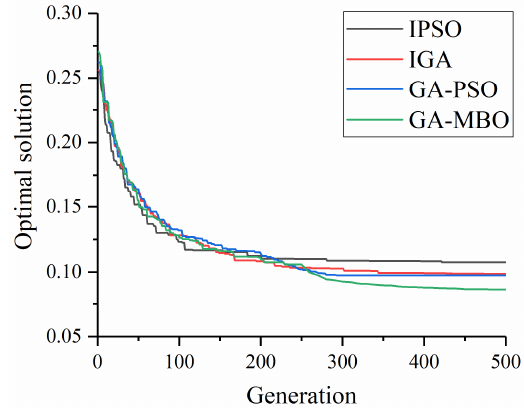
Figure 8. Iteration diagrams of four algorithms.